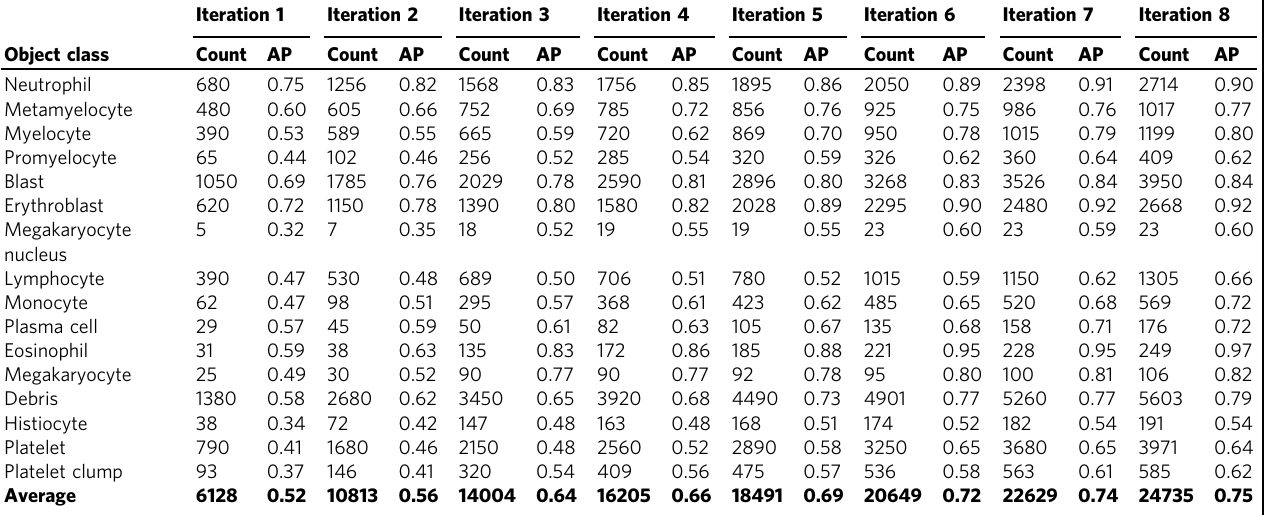
Table 4 Performance result of using active